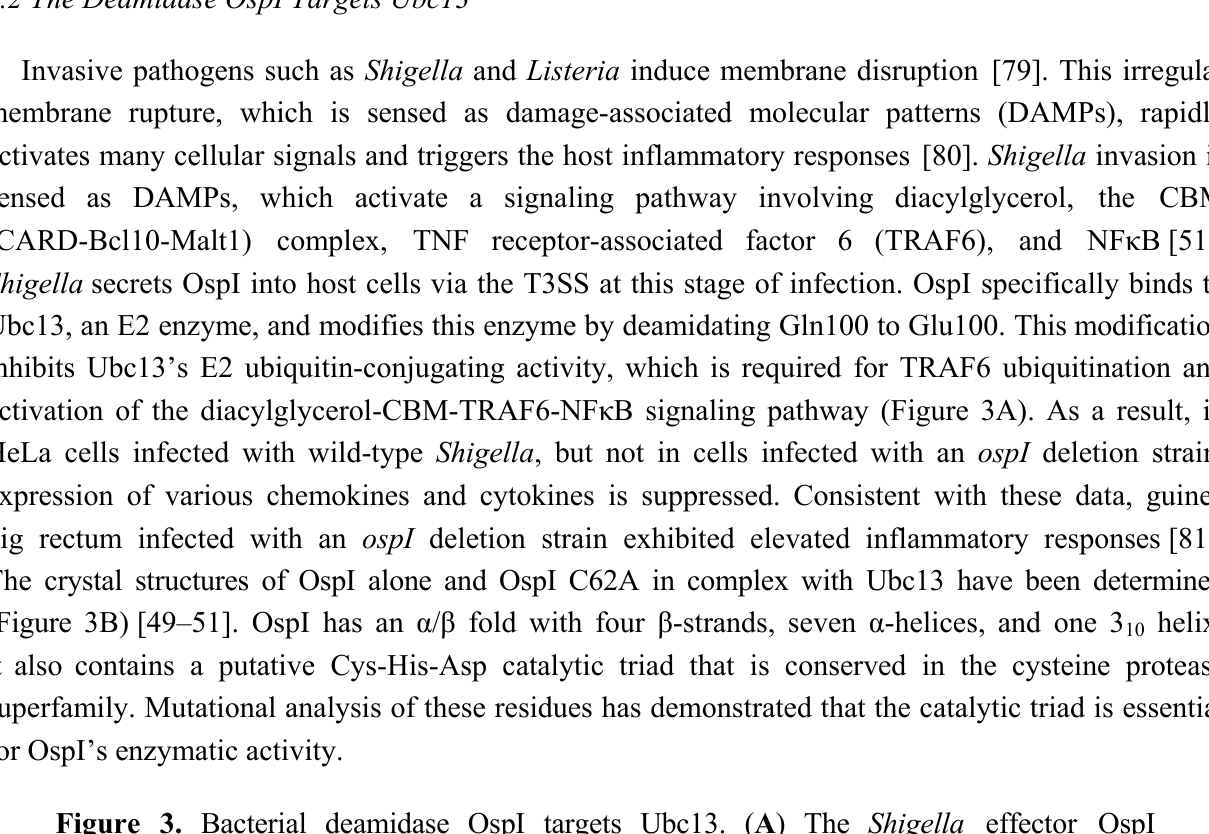
Figure 3. Bacterial deamidase OspI targets Ubc13. ( A ) The Shigella effector